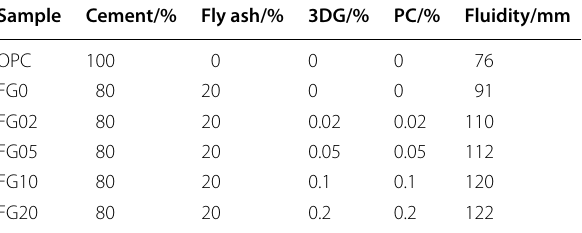
“0,” “02,” “05,” “10,” and “20,” respectively, indicate that the weight percentage of 3DG is 0%, 0.02 wt%, 0.05 wt%, 0.1 wt%, and 0.2 wt% of cement and fly ash mixture. F fly ash, G graphene with three-dimensional structure.